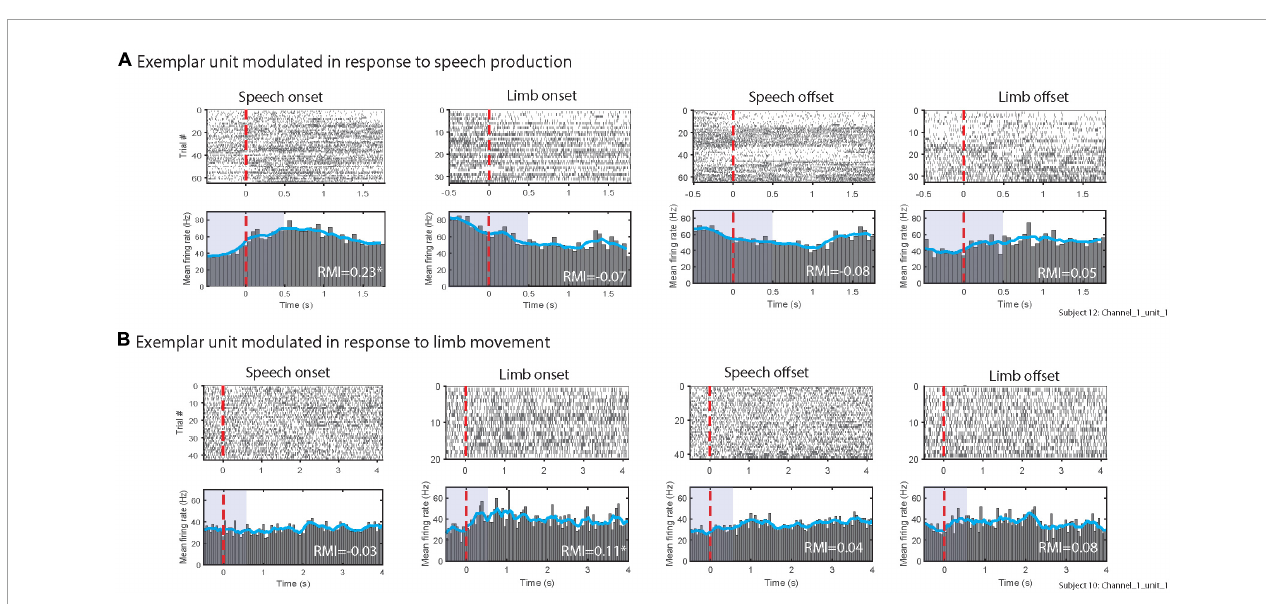
FIGURE3 Exemplary multi-unit clusters firing patterns in response to (A) speech, (B) limb movement. The top rows of (A,B) show raster plots of spikes during individual trials. Bottom rows of panels (A,B) illustrate peri-stimulus time histograms. Blue lines in histograms display the smoothed mean of firing rates. The red vertical lines show the speech and limb movement onsets (left panels) and offsets (right panels). RMI values for each alignment are listed; ∗ indicates units were significantly modulated as 95% confidence interval did not include 0. Purple shaded areas in peri-stimulus time histograms indicates the time windows used to calculate RMIs.